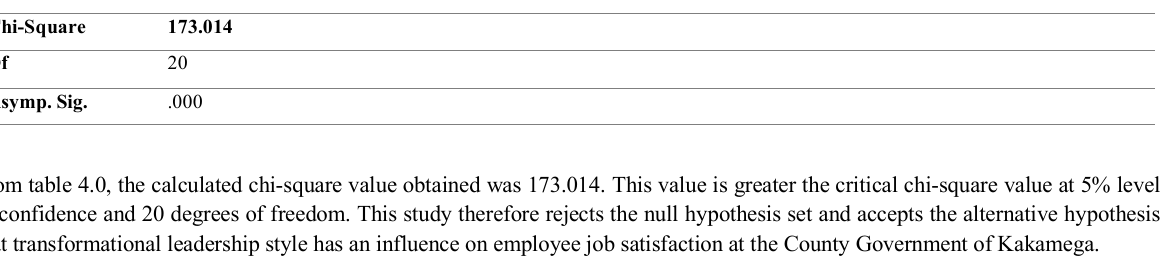
Table 4: Chi-Square Test for Transformational Leadership and Job